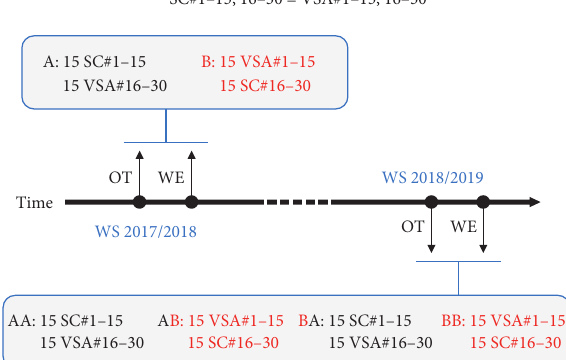
Figure 1: Schematic drawing illustrating the study design. The initial formative online test (OT) contained 30 online questions in the winter semester 2017/2018 (WS 2017/2018) in medical students at the Medical School, Halle-Wittenberg (single choice, SC or very short answer, VSA). Two groups A and B were randomly formed. Group A was online presented with 15 different SCs (labeled SC#1–15) and then subsequently 15 VSAs (labeled VSA#16–30). In group B, pairs in reverse order were formed: first 15 VSAs (labeled then VSA #1–15) and then subsequently 15 SCs (labeled then SC#16–30). In the winter semester 2018/2019 (WS 2018/2019), the same students got the same questions in different combinations as indicated. WE, written obligatory